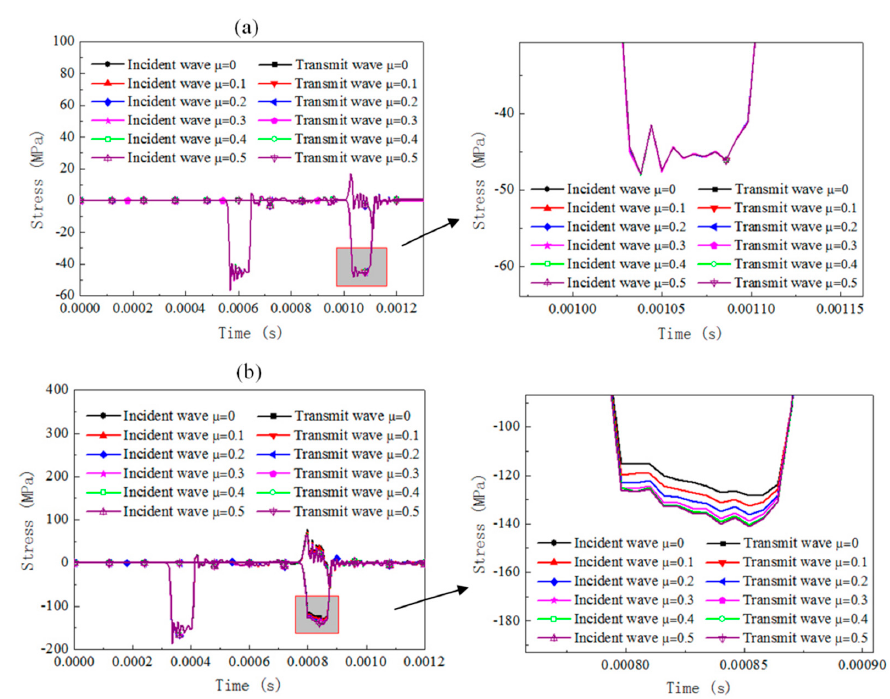
Figure 6. Comparison of the reflected and transmitted waves under di ff erent friction conditions and initial impact velocities for rate-dependent elastic-plastic material (cylinder specimen with a slenderness of 0.66). ( a ) Impact velocity of 3 m / s, ( b ) impact velocity of 10 m /